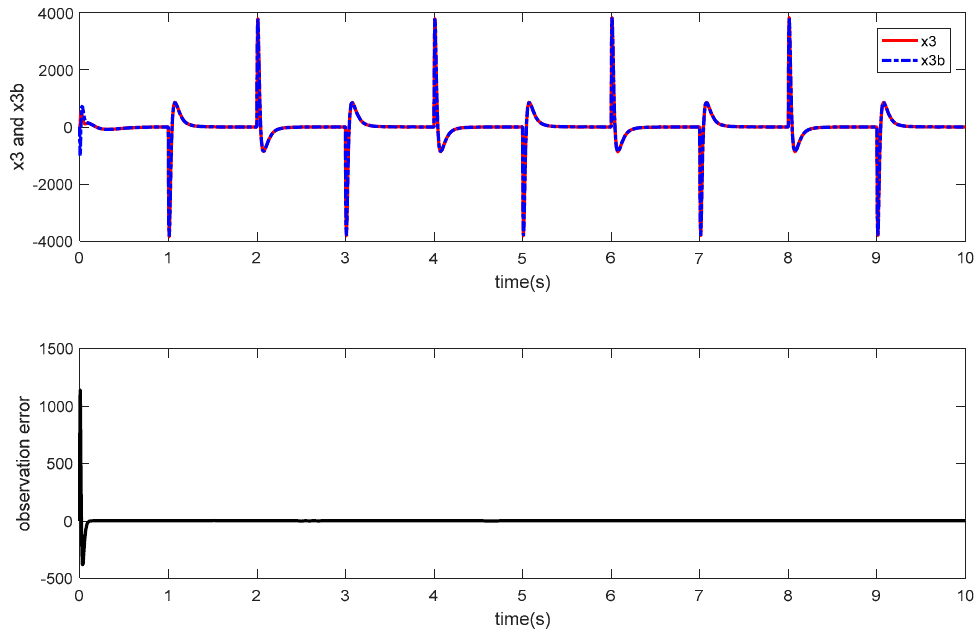
Figure 13. Comparison of the actual and estimated values of the system input.